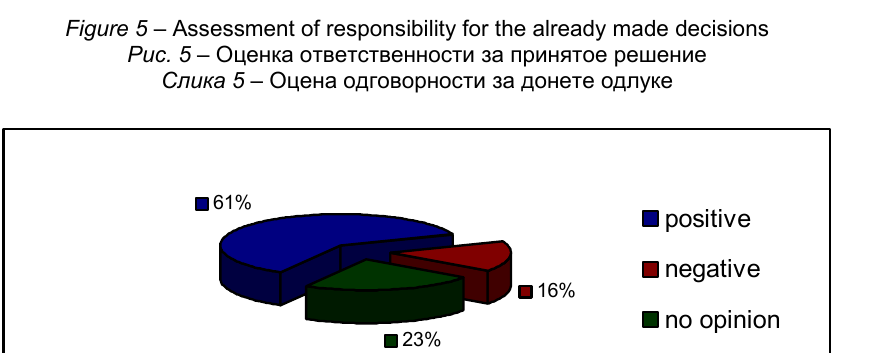
Figure 6 – Assessment of maintaining operational capabilities of units Рис . 6 – Оценка поддержки операционных способностей